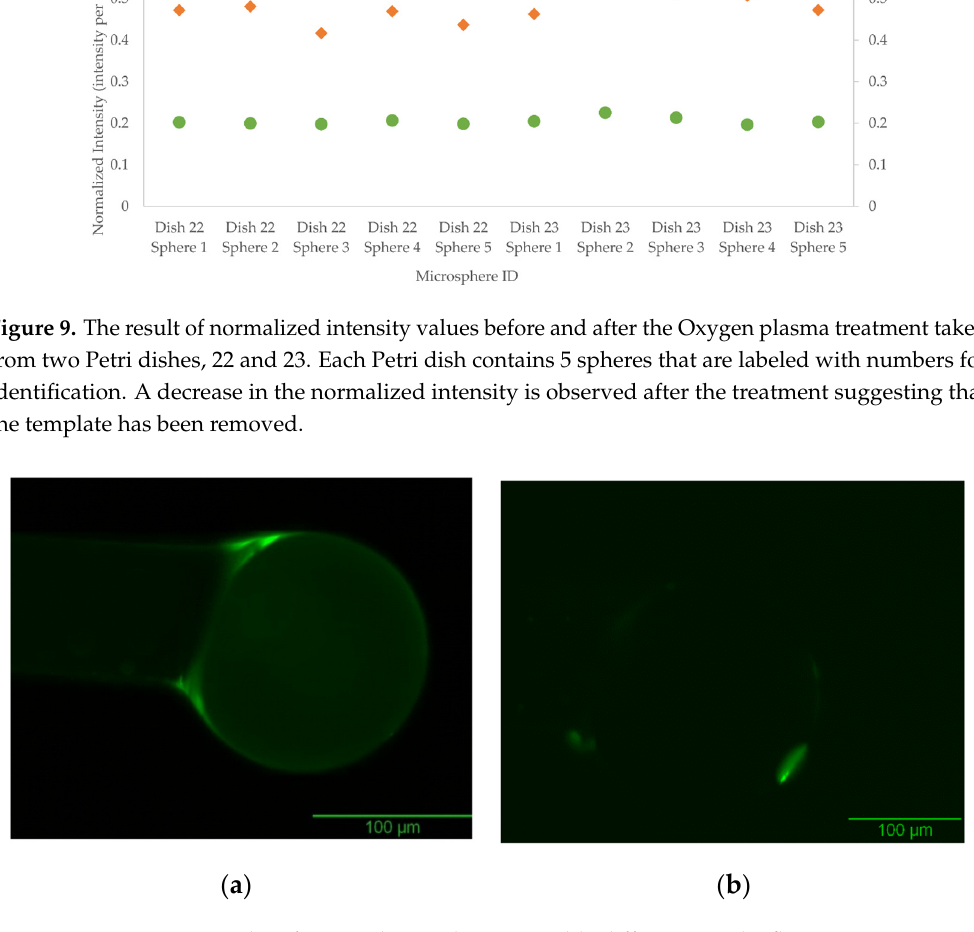
Figure 10. Images were taken from Dish 23 Sphere 3. Visible difference in the fluorescence intensity between two phases. ( a ) Pre-extraction; ( b ) Post-extraction. This particular image showed 59% loss in the intensity value after the extraction. The average intensity loss for this data set was calculated as 58%.